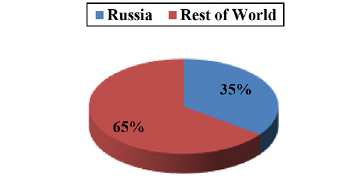
Figure 2. European imports of natural gas